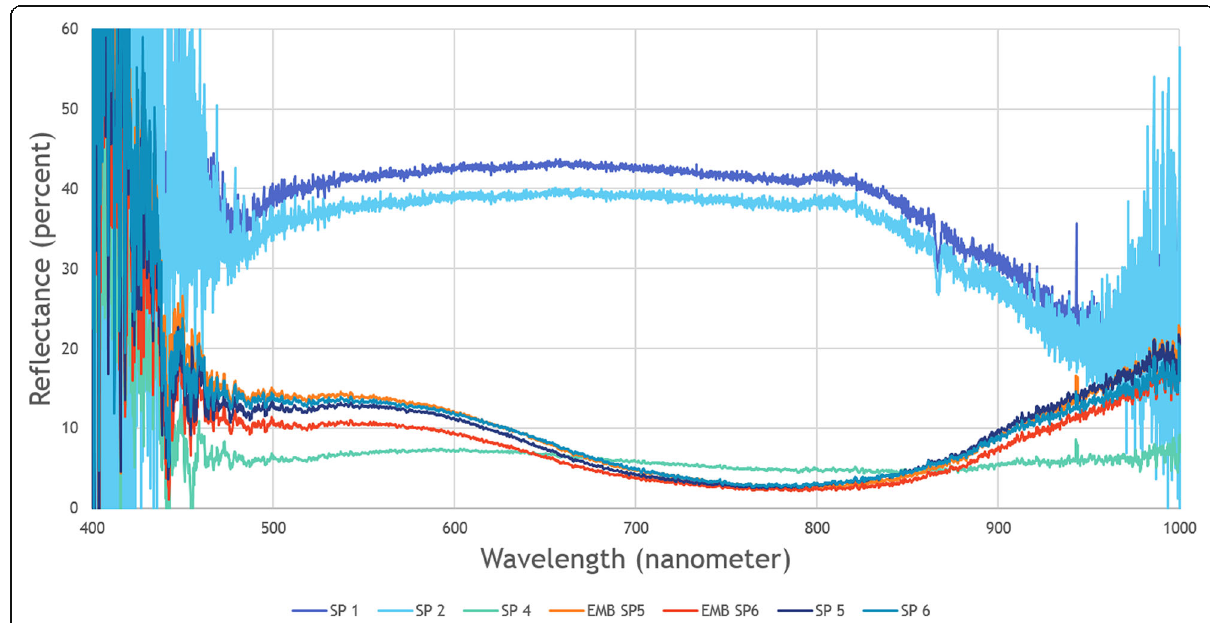
Fig. 5 The spectral plot at the Visible to Near Infrared (NIR) wavelength showing the average reflectance curves of water at the sampling stations